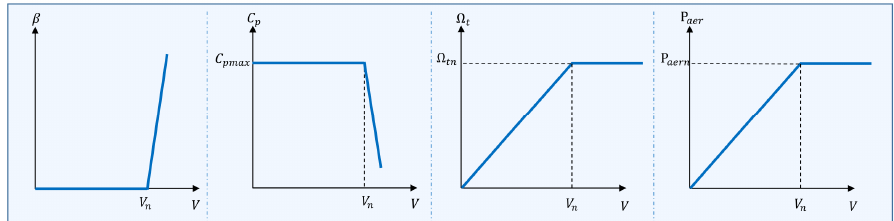
Figure 4. Evolution of different wind turbine characteristics.